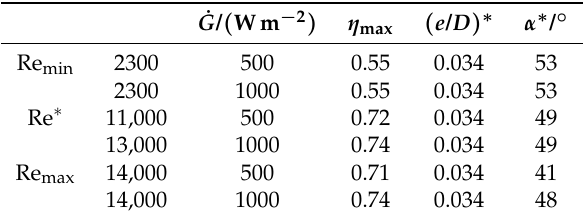
Table 3. Maximum efficiency and optimum roughness parameters according to the model developed by Lanjewar et al.